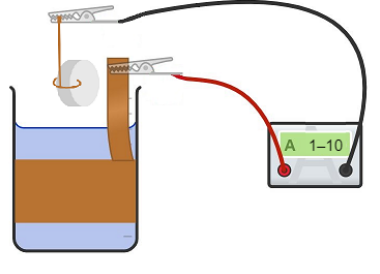
Figure 2. Scheme of copper electroplating.